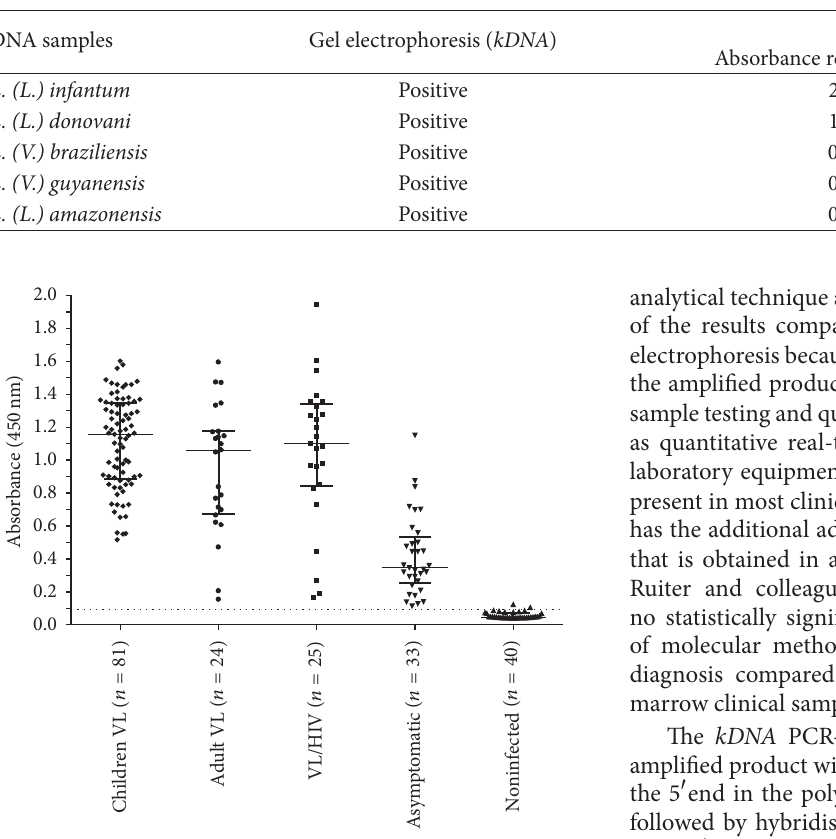
Table 1: Analytical specificity of the PCR detected in 6% polyacrylamide gels and the kDNA PCR-ELISA using DNA extracted from different Leishmania species.